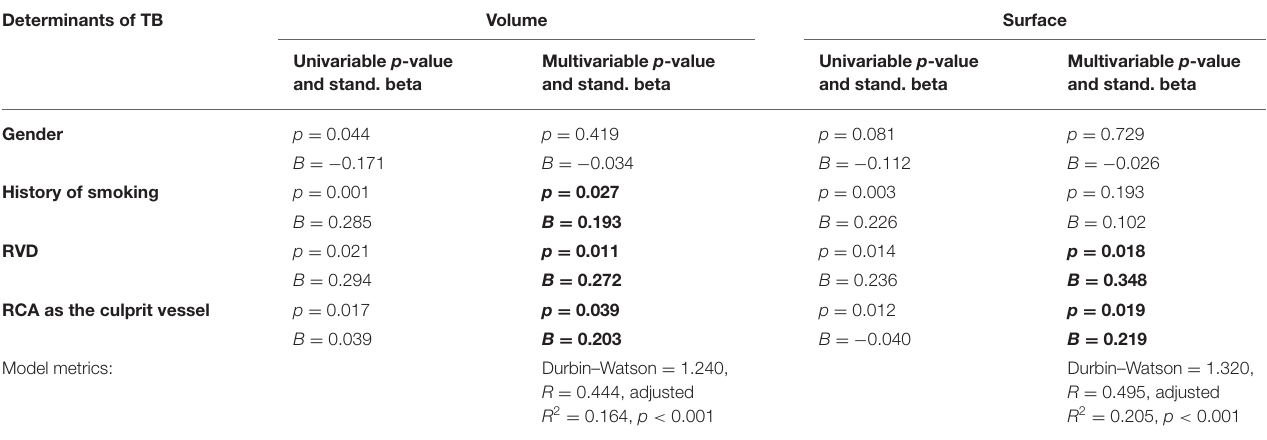
TABLE 4 | Determinants of extracted thrombus burden characteristics. Determinants of TB Volume Surface